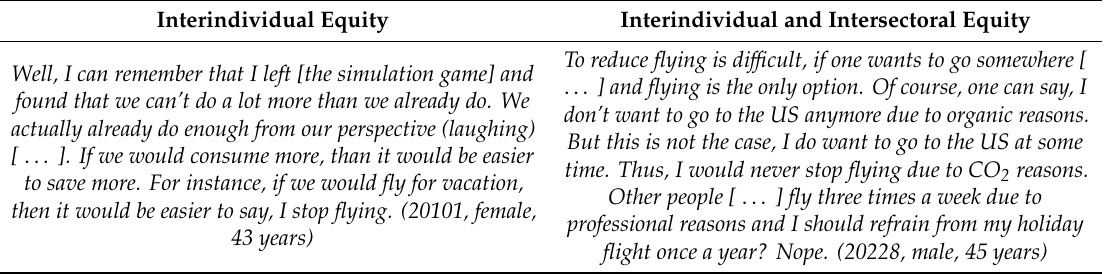
Table 9. Di ff erent perspectives on equity illustrated by the example of air travel. Interindividual Equity Interindividual and Intersectoral